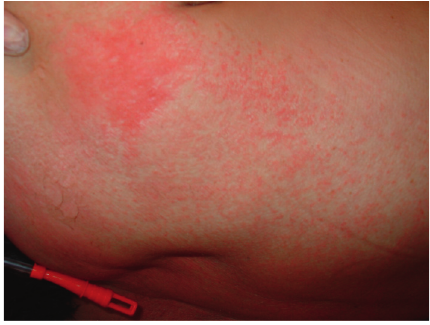
Figure 4: Morbilliform rash: maculopapular exanthem on the